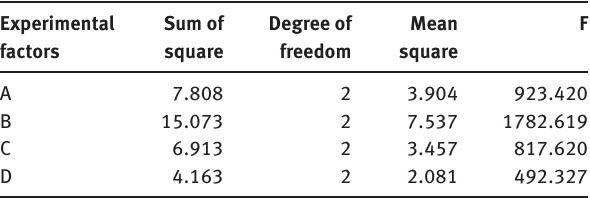
Table 4: Variance calculation of average diameter of nanocapsules.